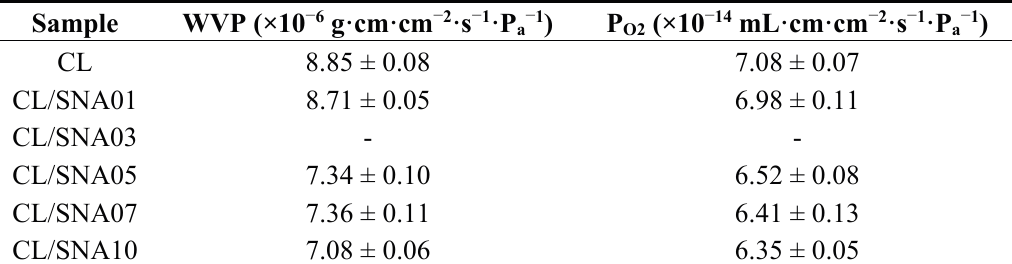
Table 2. Effects of SNA content on barrier properties of nanocomposite